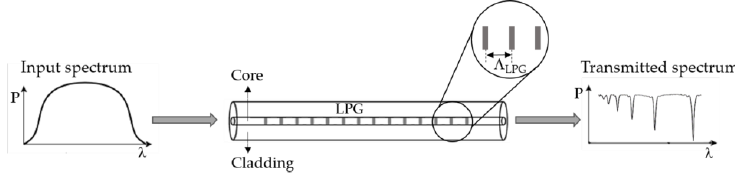
Figure 8. Schematic representation of a LPG.